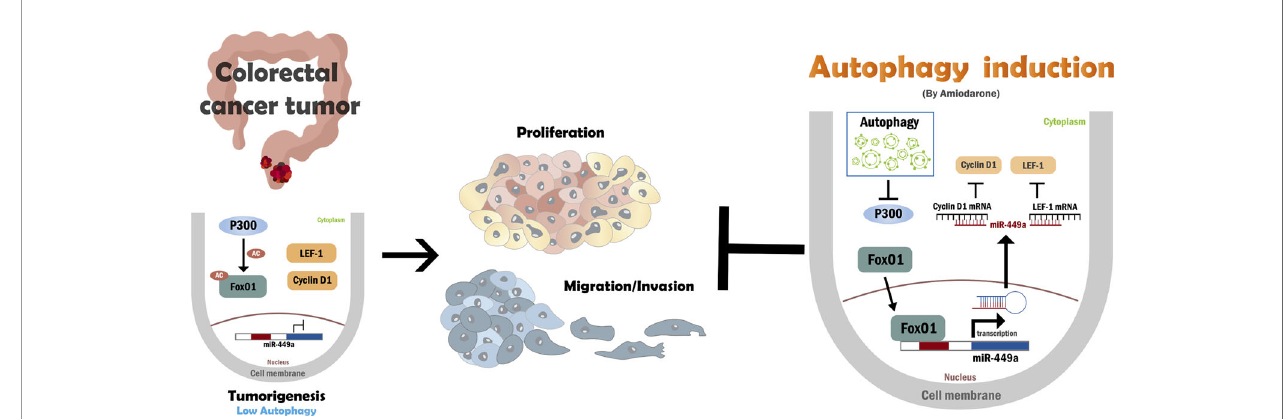
FIGURE 6 | A schematic hypothesis of autophagy regulates miR-449a, LEF-1, Cyclin D1, p300, and FoxO1 during CRC development. In colorectal cancer, low autophagic activity leads to p300 overexpression and increased FoxO1 acetylation. Acetylated-FoxO1 remains in the cytoplasm and prevents its transcriptional activation of miR-449a. Subsequently, the proteins of miR-449a target genes LEF-1 and cyclinD1 remain at high levels, which are responsible for the promotion of CRC tumorigenesis. Autophagy induction by amiodarone degrades p300 protein expression and promotes FoxO1 translocation into the nucleus due to lack of acetylation of FoxO1. MiR-449a expression was then increased by FoxO1, which further suppresses LEF-1 and cyclin D1 expression and leads to suppression of colorectal cancer